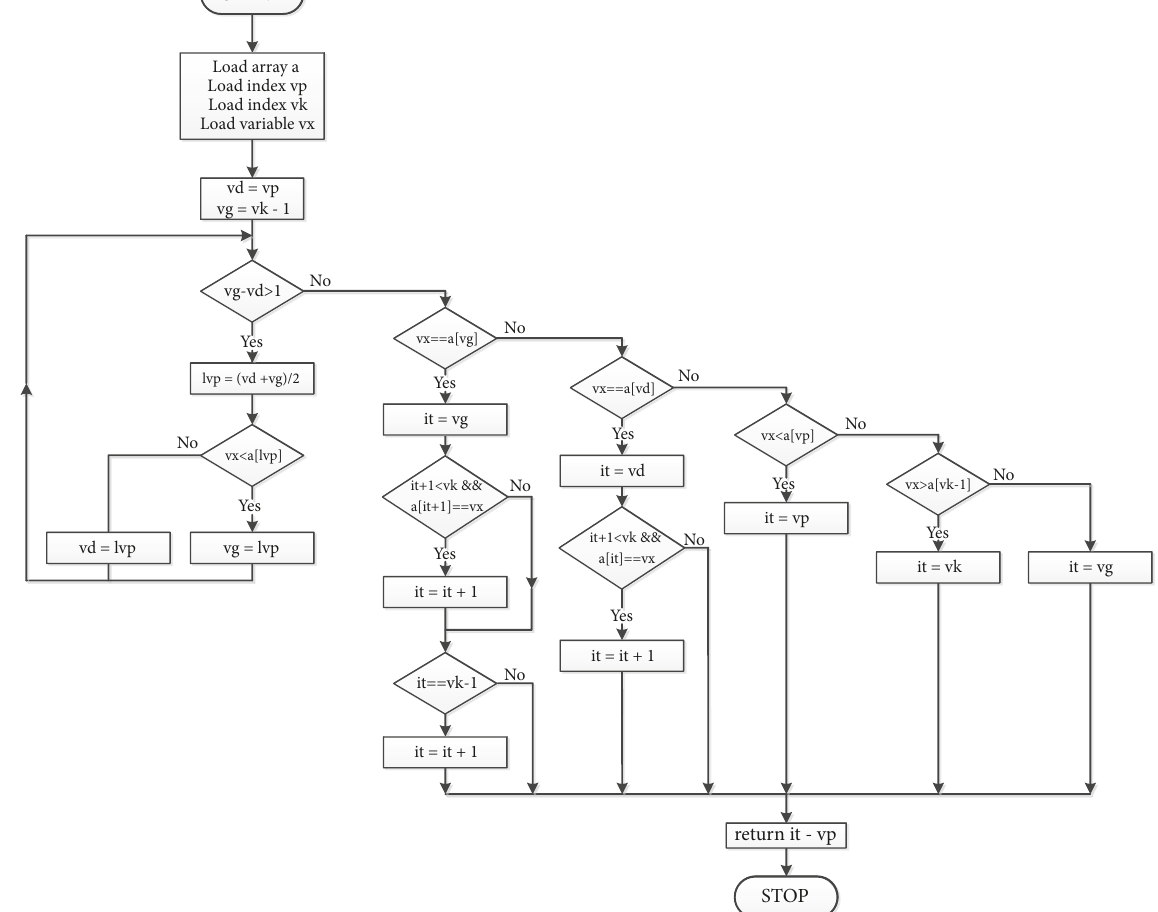
Figure 11: The block diagram of the function which returns index located in the left string.